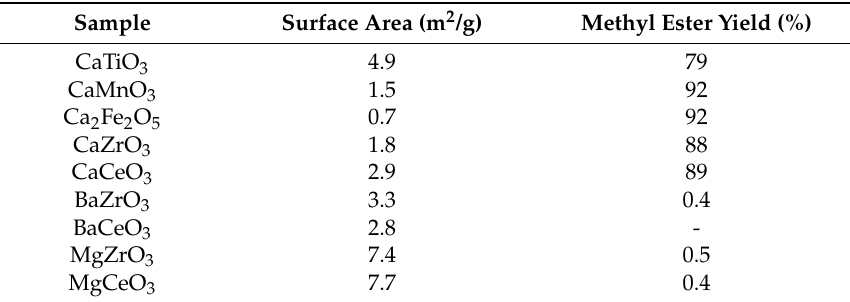
Table 11. Surface area and catalytic activities of metal oxides.